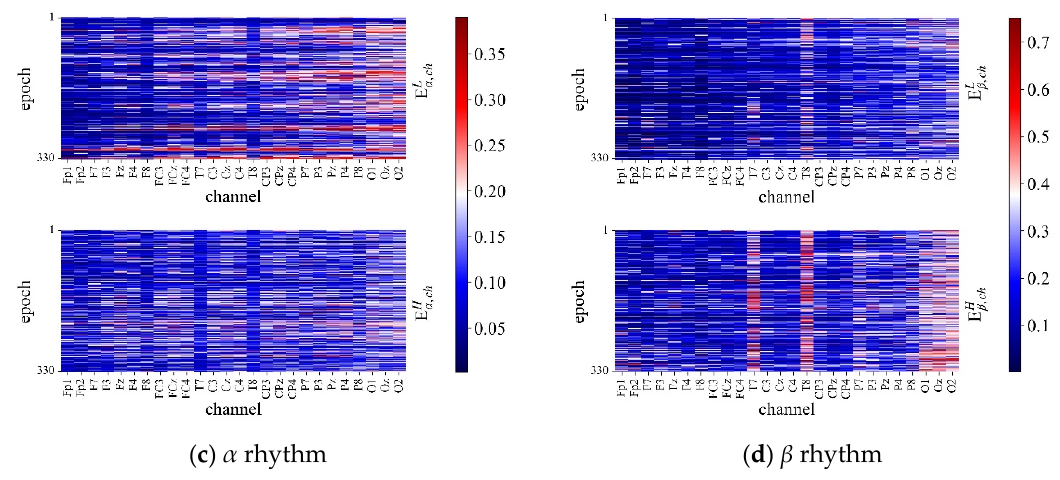
Figure 3. Energy–channel–epoch heatmaps for Sub 1 in the first experimental period.